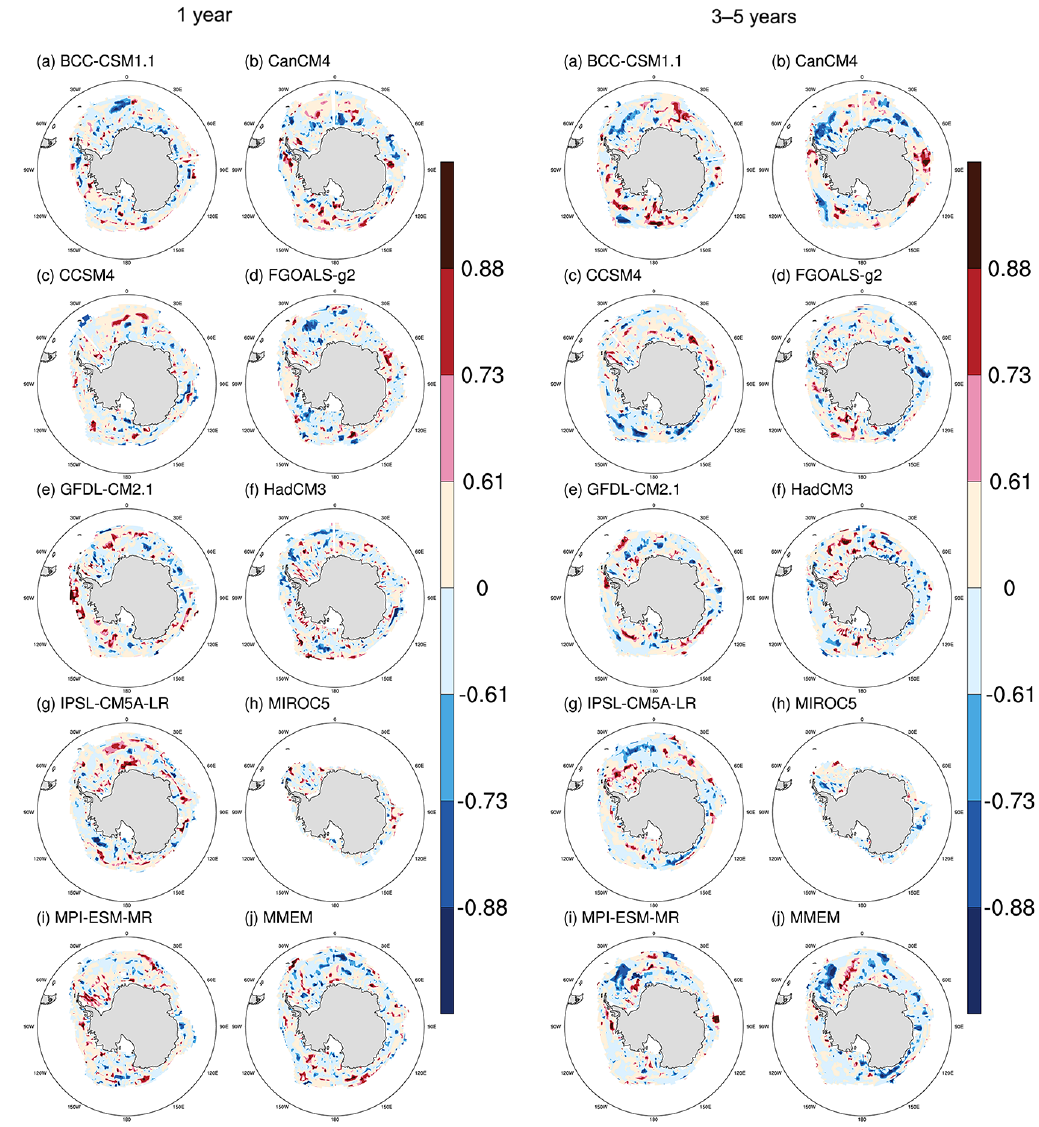
Figure 17. Same as Fig. 16, but for detrended September sea ice concentration